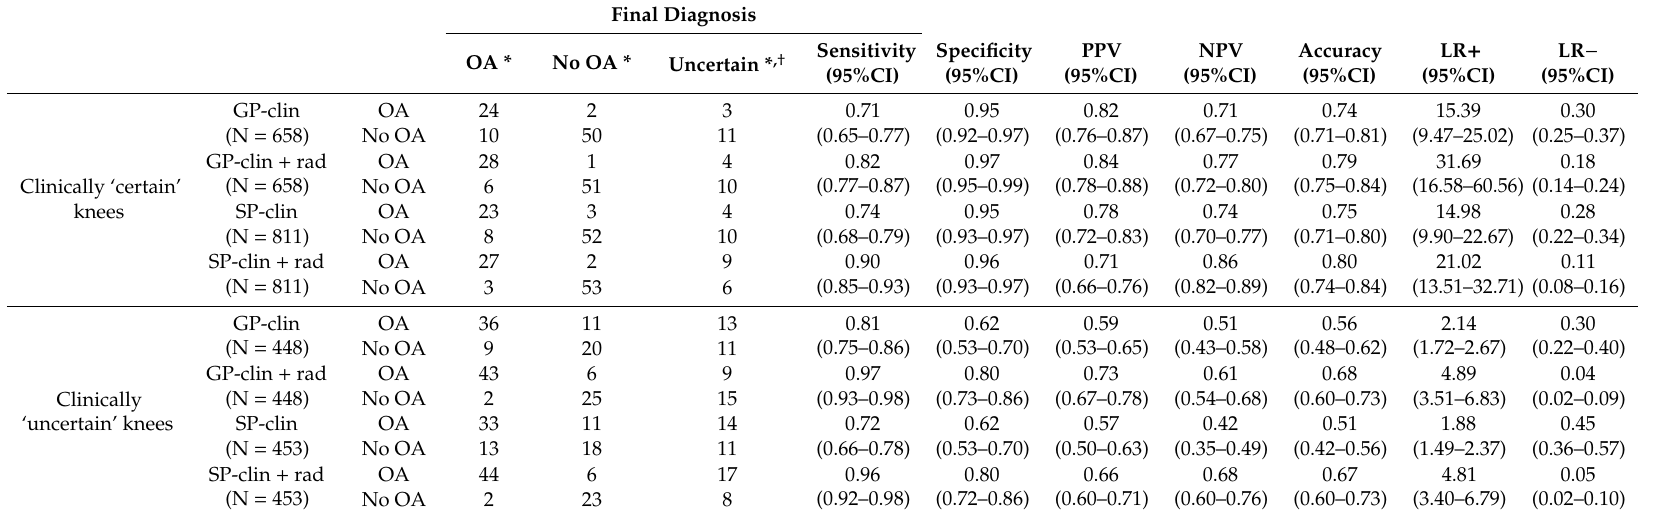
Table 5. Comparing experts’ clinically certain / uncertain diagnoses to consensus based final